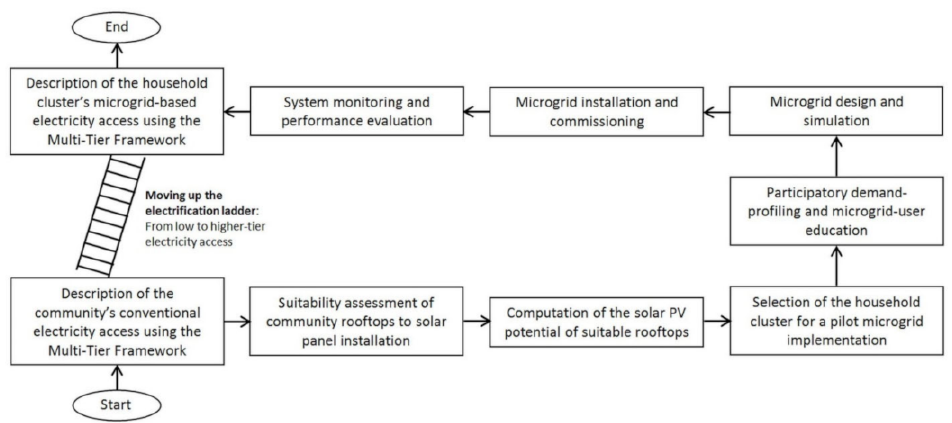
Figure 1. Diagram showing the steps in the implementation of the moving up the electrification ladder